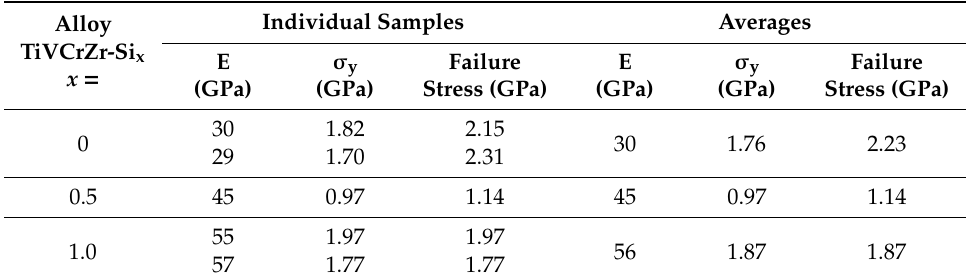
Table 2. The mechanical properties derived from compression testing of the alloys Si x TiVCrZr ( x = 0, 0.5,